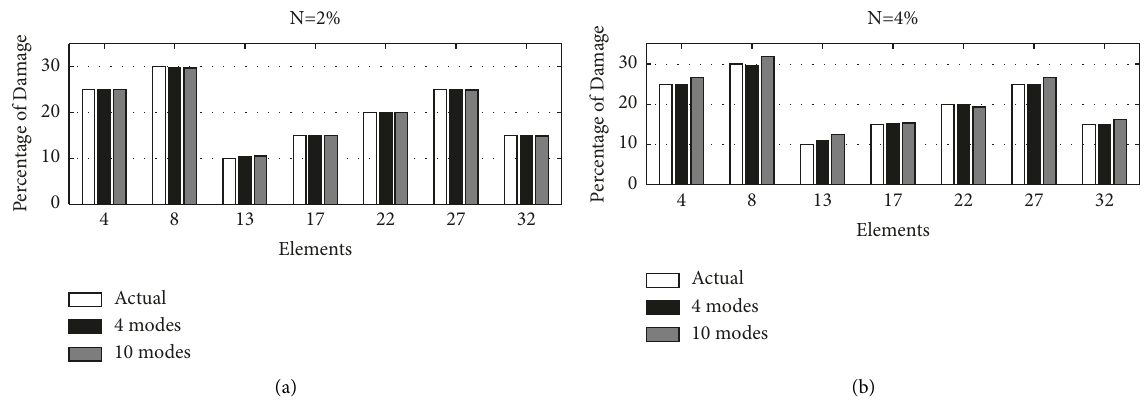
Figure 3: Damage extents obtained for the 40-element beam via EO in step 2; (a) under 2% noise, (b) under 4% noise in measured natural